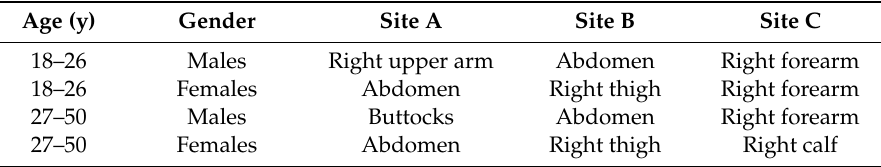
Table 1. Girth measurement sites according to age and gender.